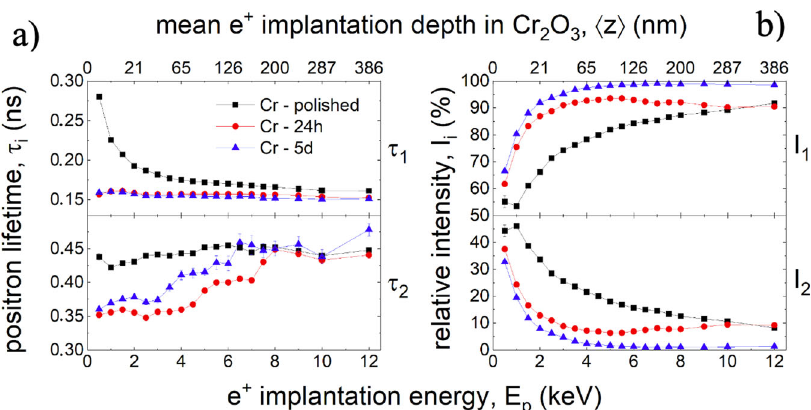
Fig. 6 VEPALS results for as-polished versus thermally oxidized chromium. Positron lifetime components τ i ( a ), their relative intensities I i ( b ), and standard errors were calculated from PALS fi t spectra decomposition 47 for as-polished Cr versus air oxidized Cr. Most error bars are smaller than the size of the symbols used for data points representation and reside within the respective symbols.